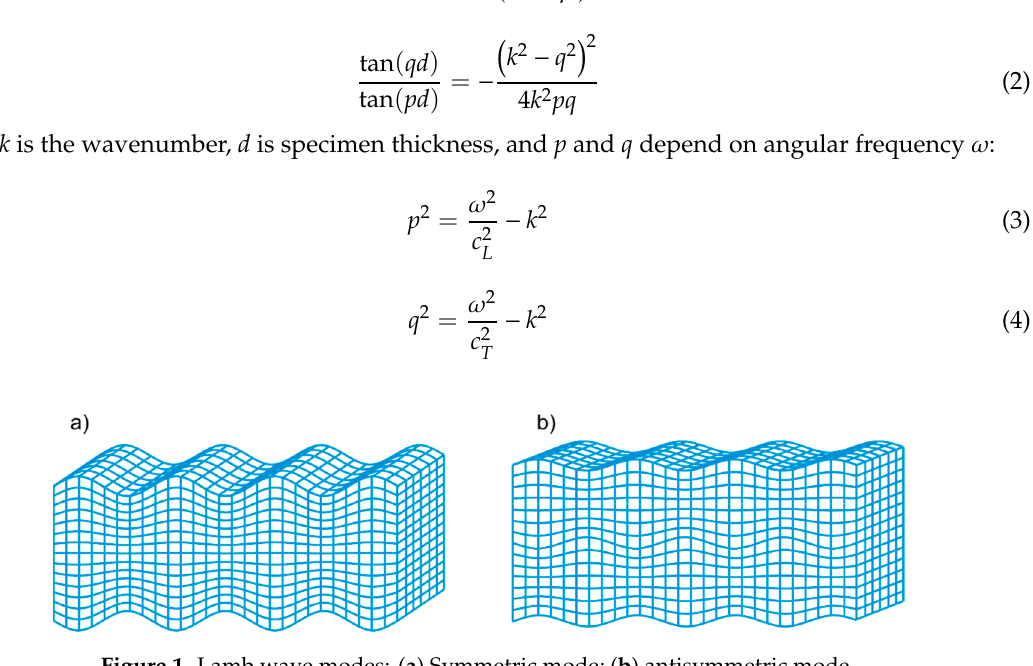
Figure 1. Lamb wave modes: ( a ) Symmetric mode; ( b ) antisymmetric mode.